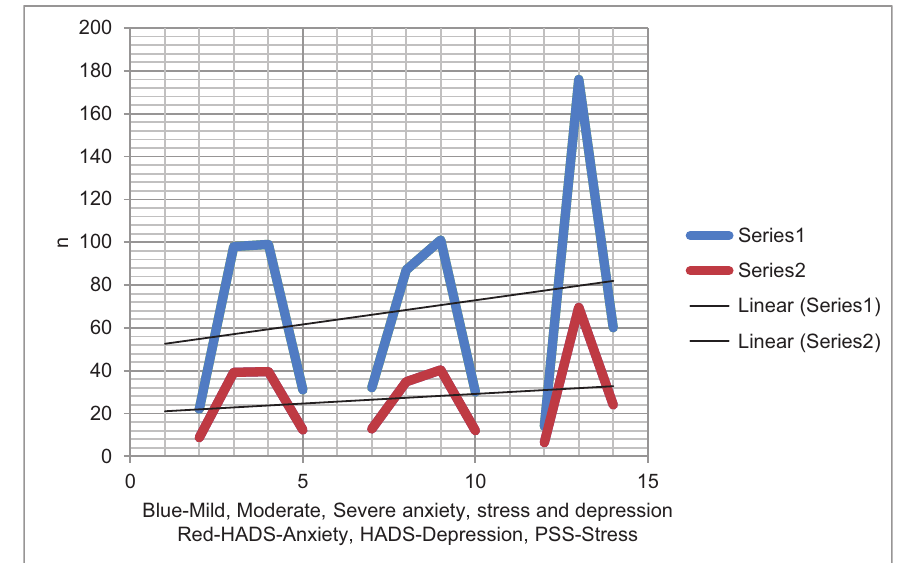
Figure 1: Distribution of anxiety, depression, and perceived stress in kidney cancer patients ( n =